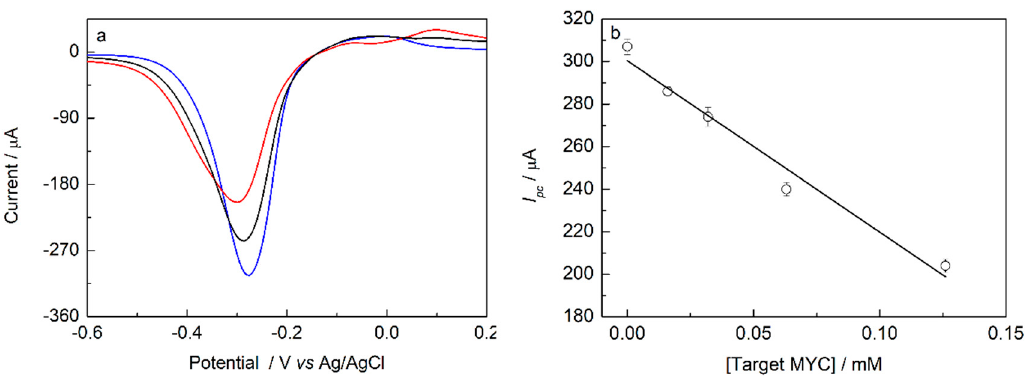
Figure 6. ( a ) Differential pulse voltamograms for methylene blue reduction content: ( ⎯ ) probe; ( ⎯ ) probe + interferent; and ( ⎯ ) probe + specific target. Amplitude: 25 mV; pulse period: 0.20 s; pulse height: 0.06 s; and ν = 20 mV/s. ( b ) Analytical curve obtained for the biosensor (mean ± SD, n = 3), being evaluated the target concentrations of: 0.000, 0.016, 0.032, 0.063, and 0.126 mM using a solution volume of 10 μ L, hybridization time of 20 min and incubation temperature of 42 °C. Intercalator: 20 μ L of AM 5.00 × 10 − 4 M.